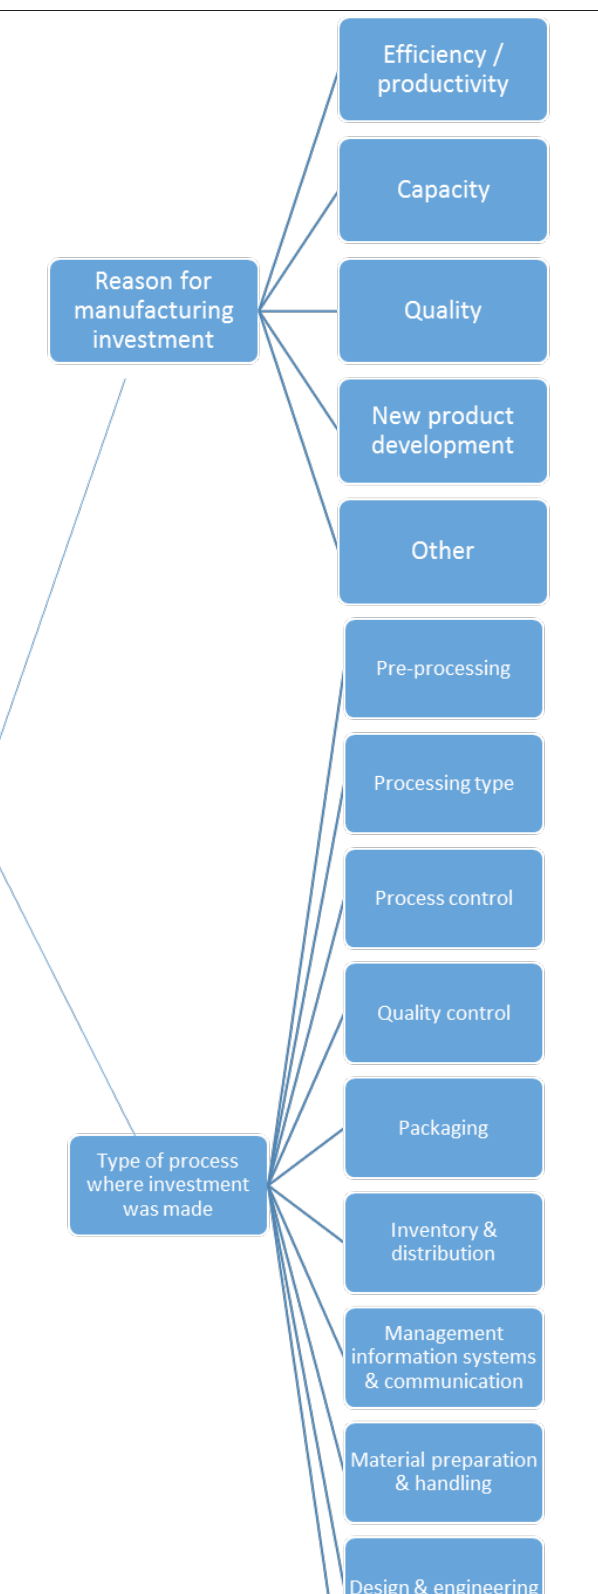
Figure 2: Further classification of manufacturing-related activities in the South African food and beverage manufacturing http://www.sajs.co.za